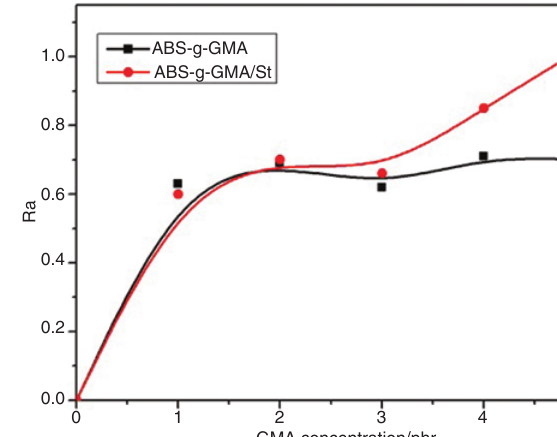
Figure 4 Variation of Mw and GD of ABS-g-GMA/St with GMA concentration.